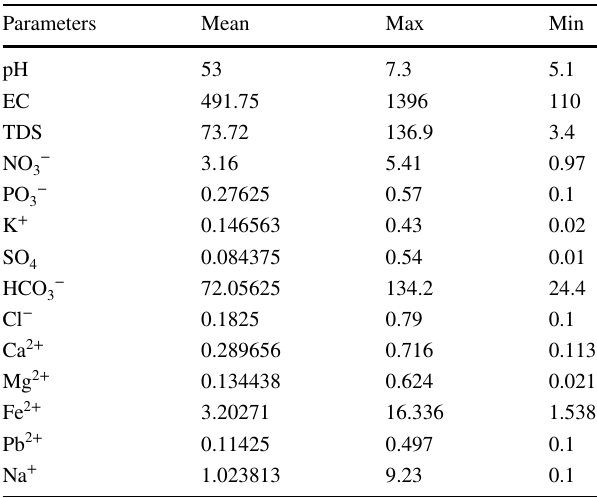
Table 4 Summary of the hydrogeochemical analysis